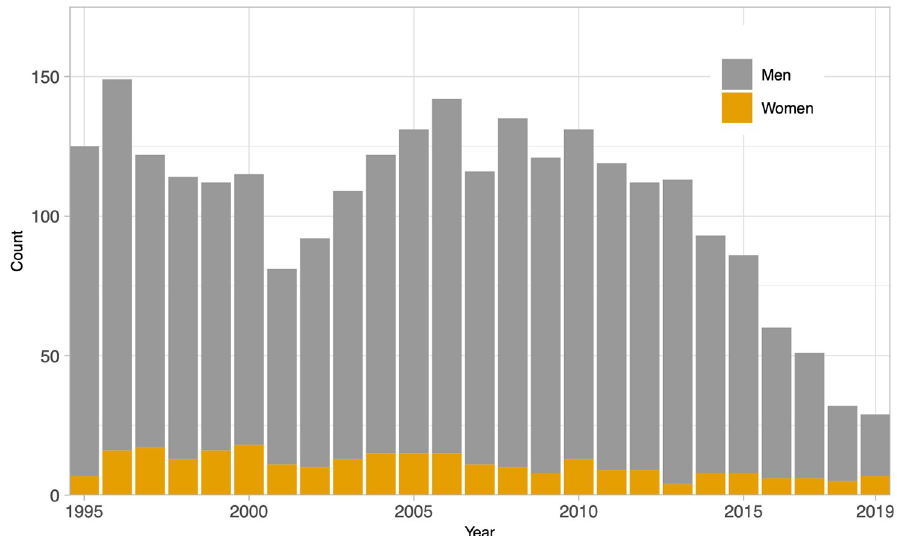
Fig 2. Distribution of new HIV diagnoses by gender and year, 1995–2019 (n = 2,612).